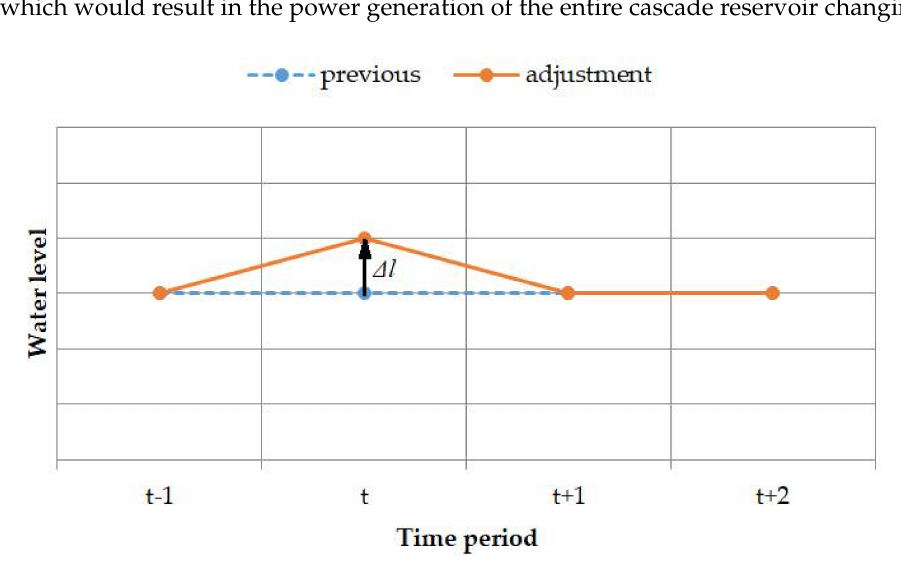
Figure 1. Adjustment in water level by a small